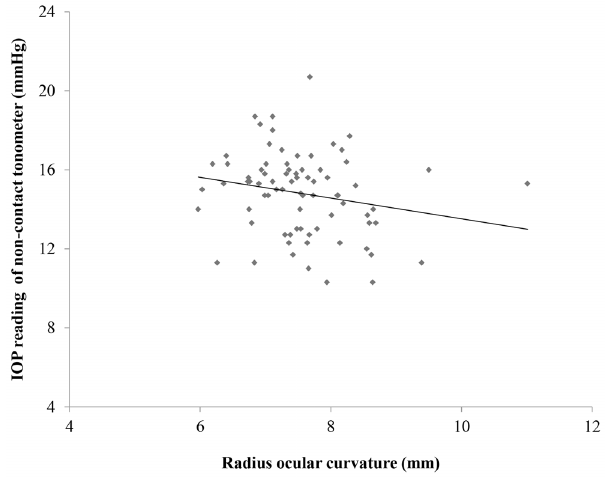
Figure 3. The relationship between the radius ocular surface and IOP. The radius ocular curvature showed a significant negative correlation with the IOP obtained using the non-contact tonometer (R 2 =0.0443, P =0.028).